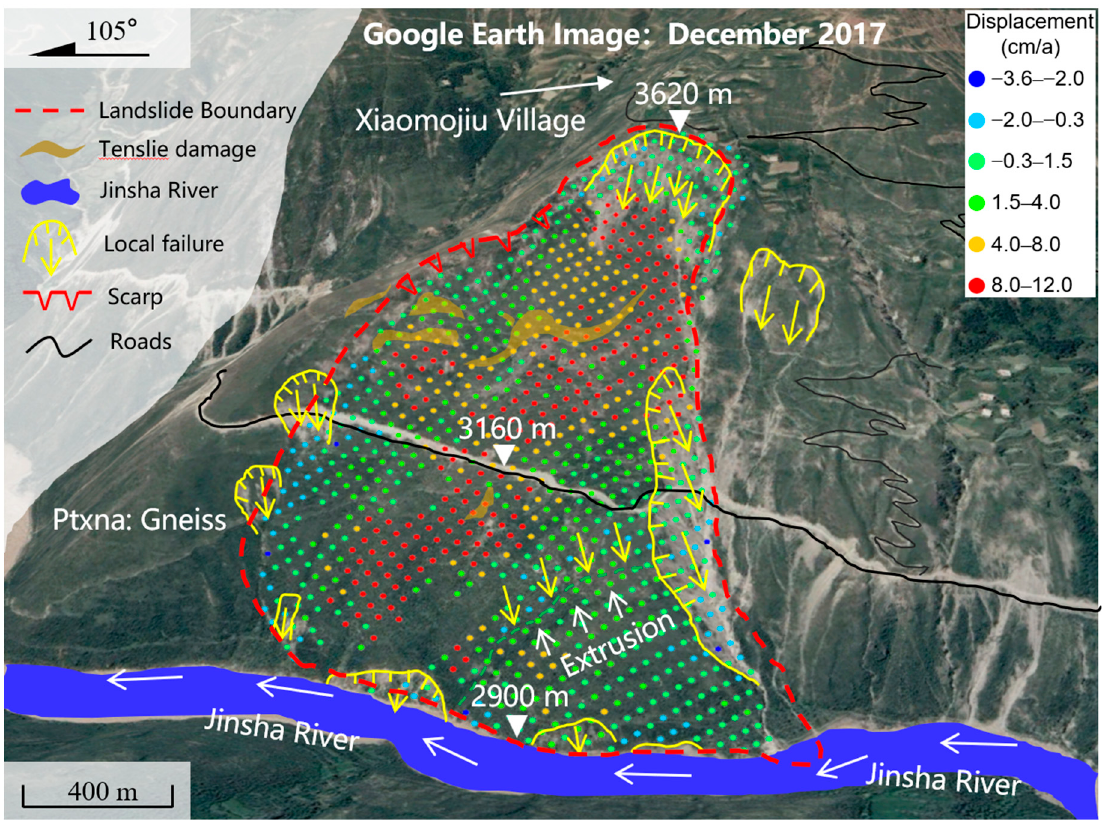
Figure 5. Diagram showing the three-dimensional morphology of the Xiaomojiu landslide from Google Earth (background: modified from © Google Earth 2021).